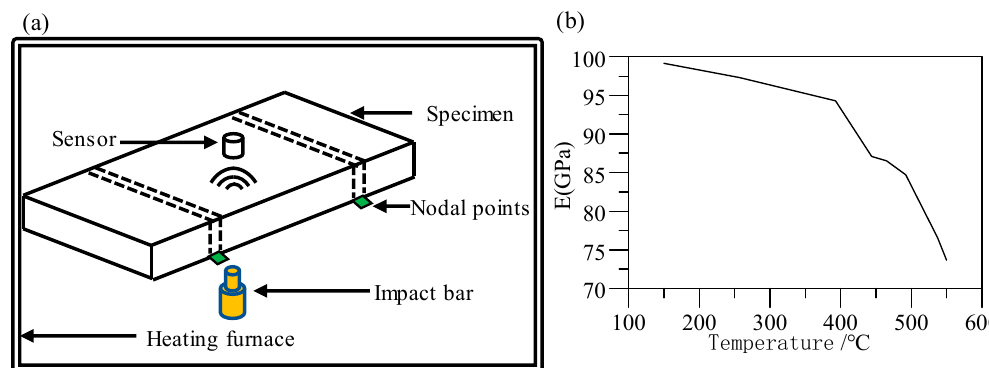
Figure 5. Measurement of elastic modulus: ( a ) illustration of the measurement setup; ( b ) diagram of